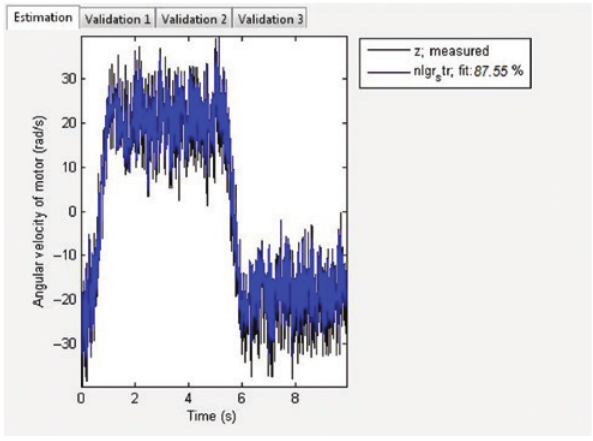
Figure 2: Fitness Value (1) of Motor.